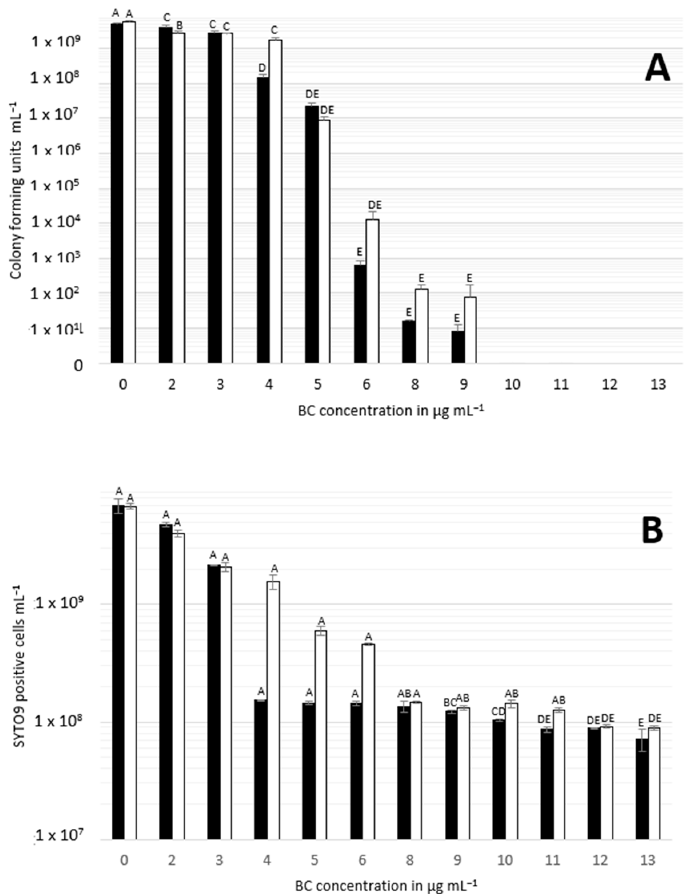
Figure 1. Colony forming units ( A ) and SYTO9-positive cells ( B ) of parent (black bars) and adapted (white bars) Listeria monocytogenes SLCC2540 following cultivation in brain heart infusion broth (BHI) containing benzalkonium chloride (BC) in various concentrations. Error bars indicate standard deviation of nine replicates. Different letters above bars within panels indicate significant differences ( p < 0.05) according to two-way analysis of variance (ANOVA).